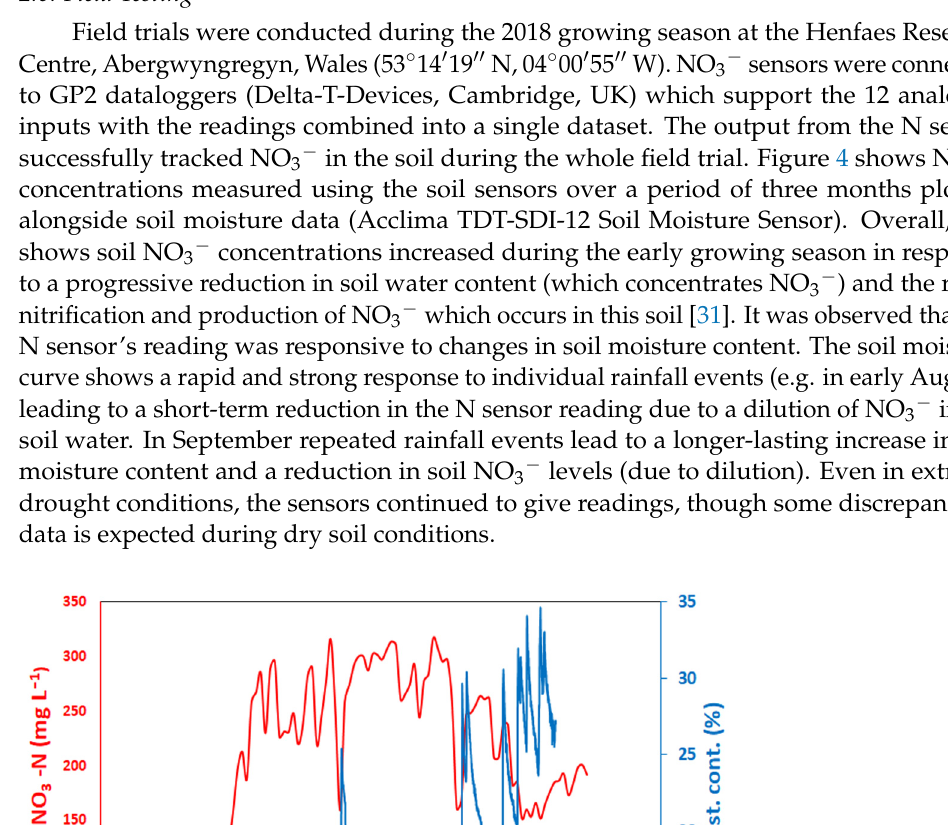
Figure 3. Correlation and regression between the nitrate levels measured by the soil N sensor and laboratory-based soil extraction and colorimetric analysis over a 3-month period. (See Table S2).